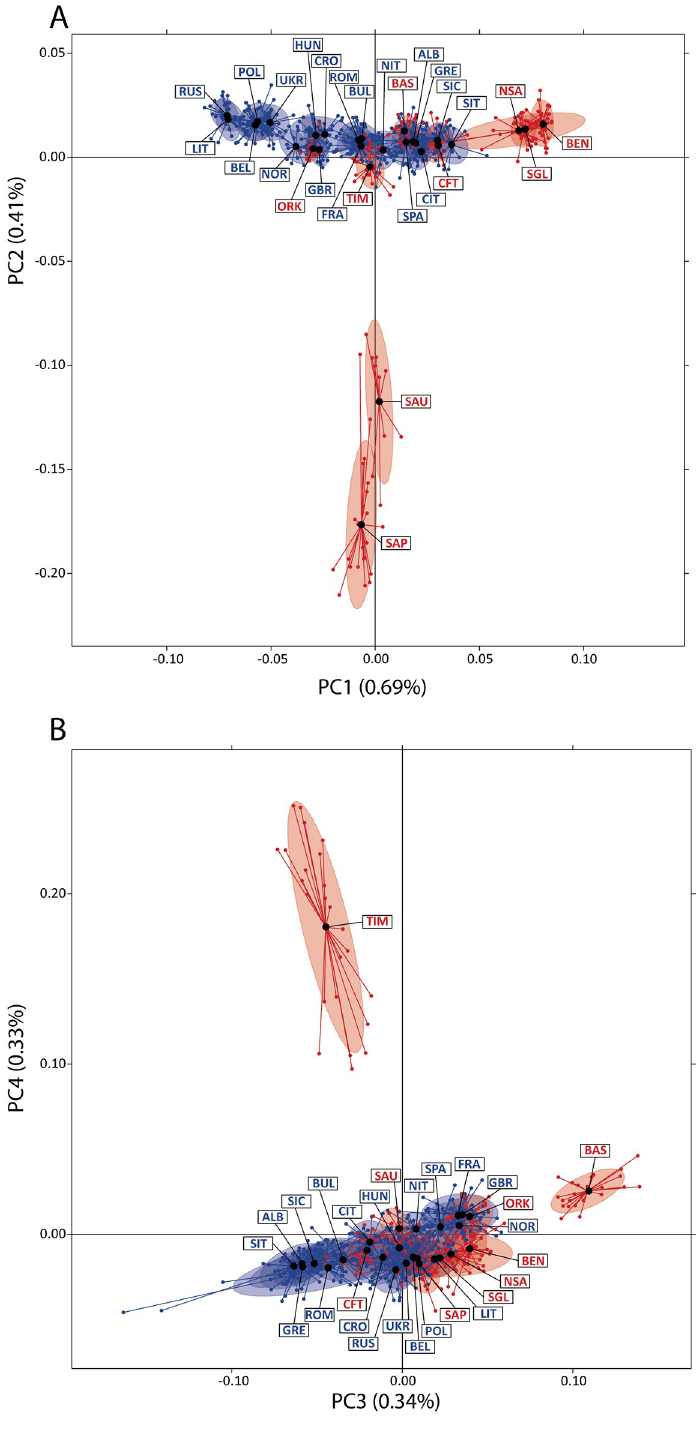
Fig 1. Principal components analysis of the isolated and open populations. (A) Plot of the first and second components and (B) Plot of the third and fourth components. Black dots represent the centroid for each population. Labels as in Table